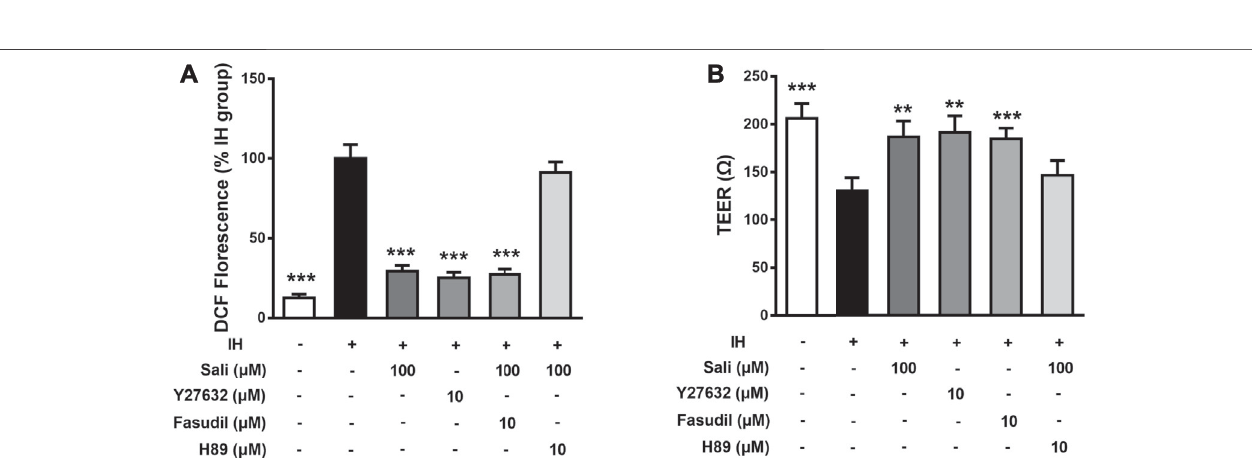
FIGURE 6 | Salidroside ameliorated IH-induced ROS overproduction and barrier dysfunction in HUVECs via the cAMP/PKA/RhoA signaling pathway. Effects of drugson ROS generation (A) and TEER (B) weredetermined inHUVECs pretreated with Sali (100 µM), H-89 (10 µM), Y27632(10 µM), orFasudil(10 µM) for 2 h before exposure to either normoxia or 72 cycles of IH. IH, intermittent hypoxia; Sali, salidroside; ROS, reactive oxygen species; TEER, transendothelial electrical resistance. All data are presented as mean ± SD of three experiments. *** p < 0.001 compared with IH group.